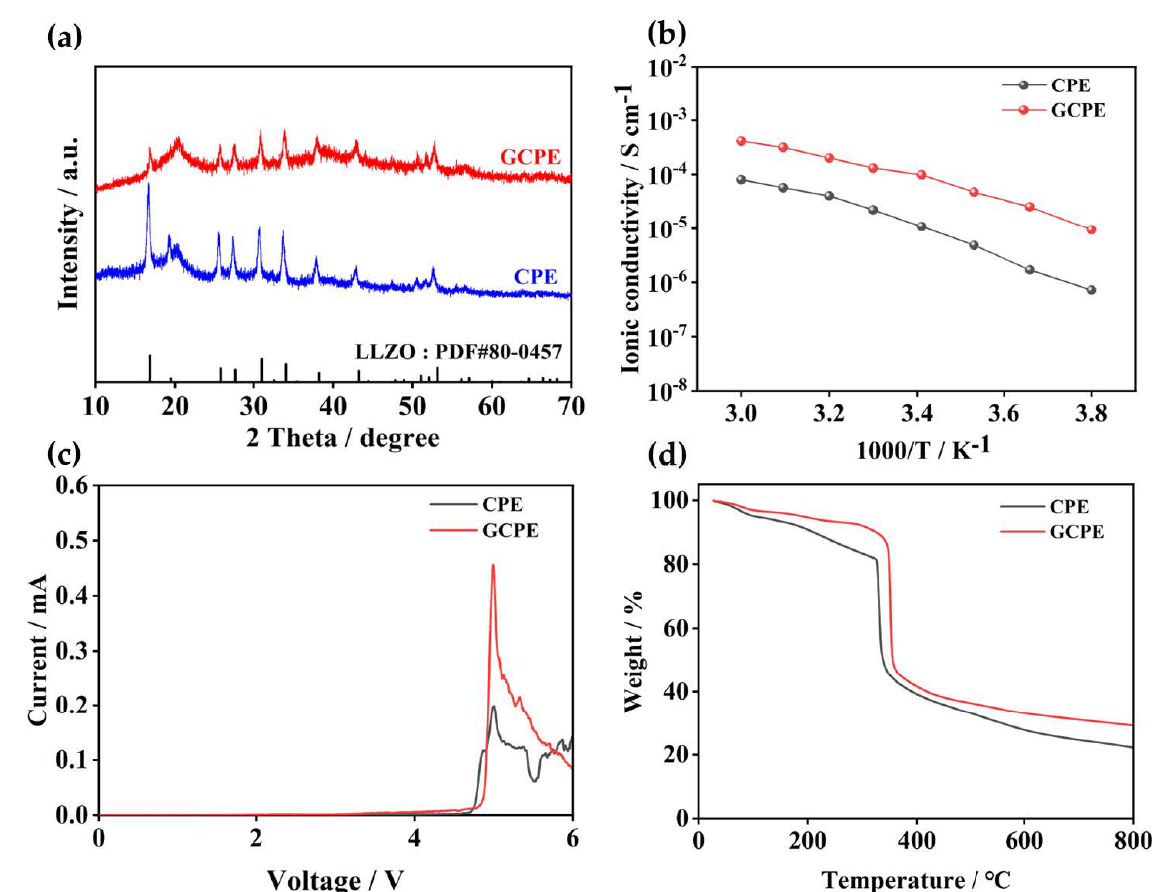
Figure 3. ( a − d ) The XRD, Arrhenius, LSV, TGA of CPE and